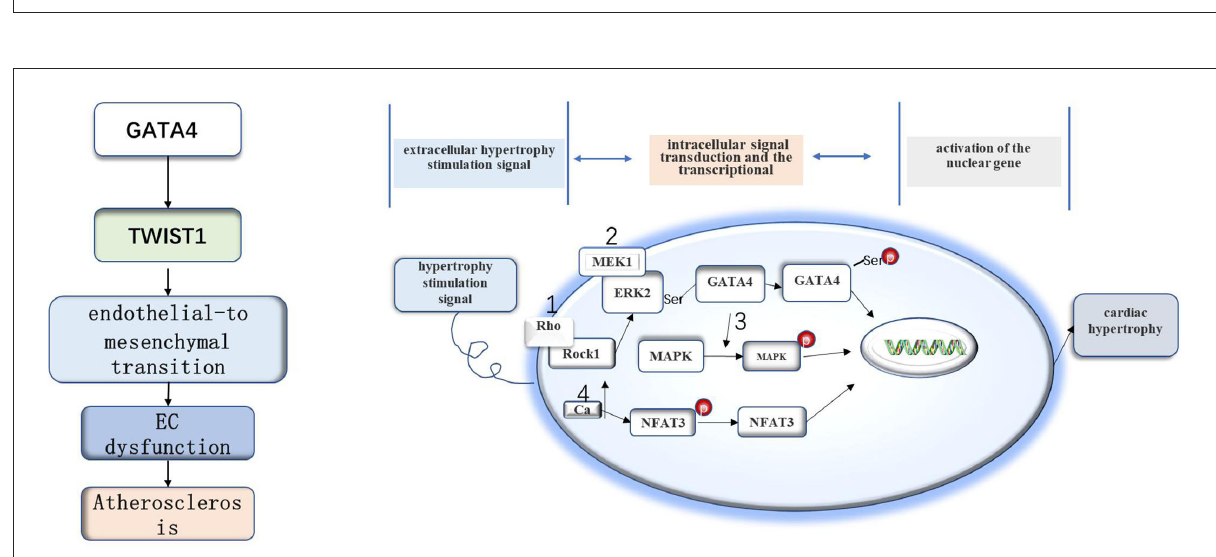
FIGURE3 The role of GATA4 in various organs and aging-related diseases. GATA4 can promote the development of heart, testis, ovary, foregut, liver, and ventral pancreas and can lead to heart disease associated with